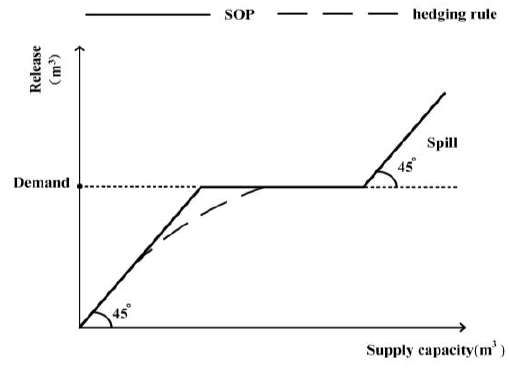
Figure 1. Curves of HR and SOP.